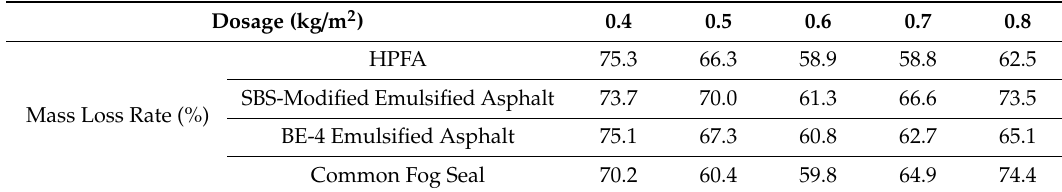
Table 8. Mass loss rate after 100,000